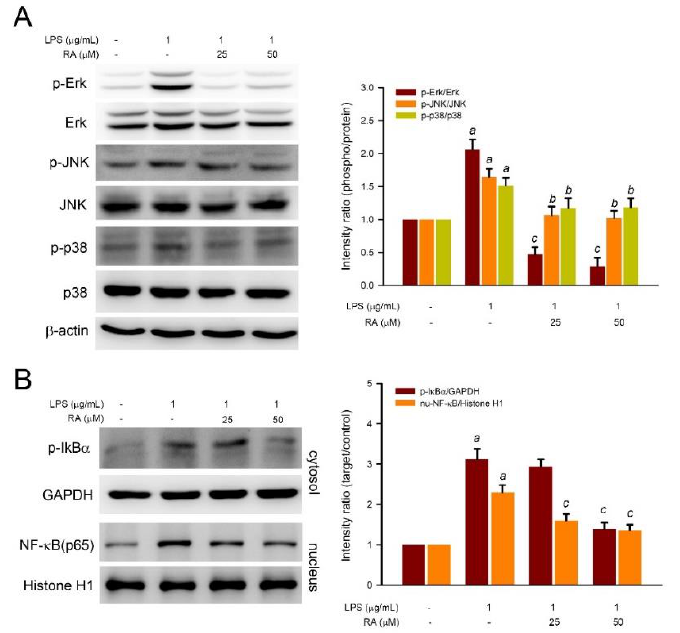
Figure 3. Effect of RA treatments on LPS-induced MAPK activation and NF-kB signaling. Cells were pretreated with RA at 25 or 50 μM for 1 h, then treated with LPS for 24 h. The treated cells were subjected to immunodetection of ( A ) MAPKs and their phosphorylations or ( B ) cytosol/nucleus fractionation and subsequent immunodetection of IκBα phosphorylation and nuclear NF - κB. GAPDH and Histone H1 were used as an internal control for the cytosol and nucleus fraction, respectively. Quantitative data were acquired by densitometric analysis from three independent experiments. a , p < 0.01 as compared to the control; b and c , p < 0.05 and p < 0.01 as compared with LPS alone.